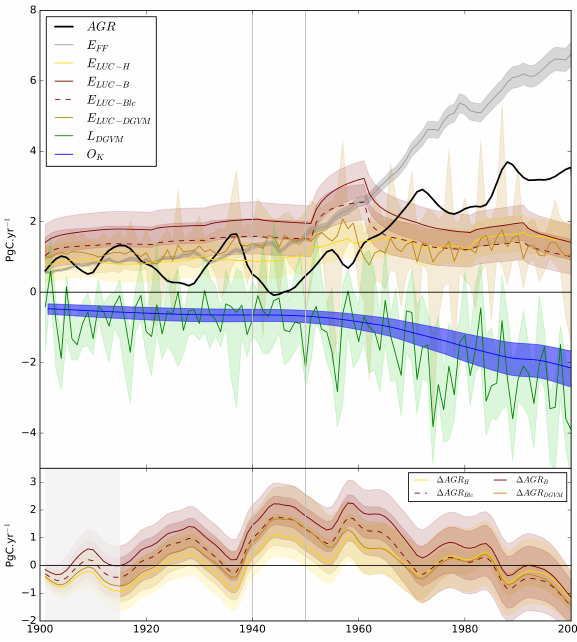
Figure 3. As in Figure 2 but for the independent estimates of sources and sinks: E FF from CDIAC, E LUC from Houghton ( H ), BLUE ( B ), and BLUE with lower C-stock changes (Blc) and DGVMs forced with LUC, ocean from Khatiwala et al. (2009) re- construction, and land sink as estimated by DGVMs forced only by CO 2 and climate. In the bottom panel, the difference between observed AGR and AGR H , AGR B , AGR Blc , and AGR DGVM is